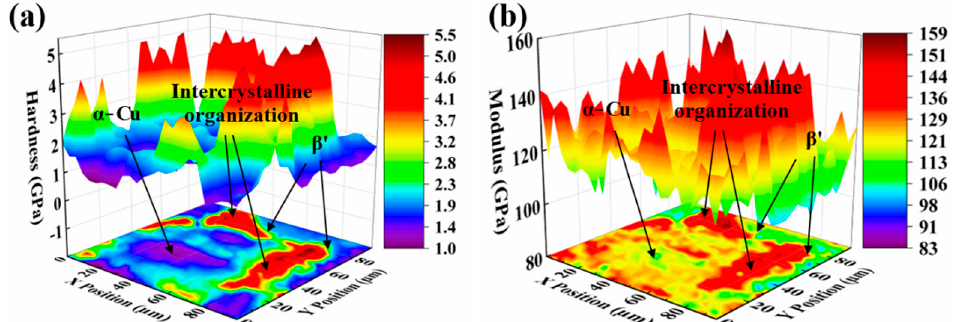
Figure 3. Characteristics of the initial semi-solid CuSn10P1 alloy: ( a ) 3D microhardness, ( b ) 3D modulus of elasticity.